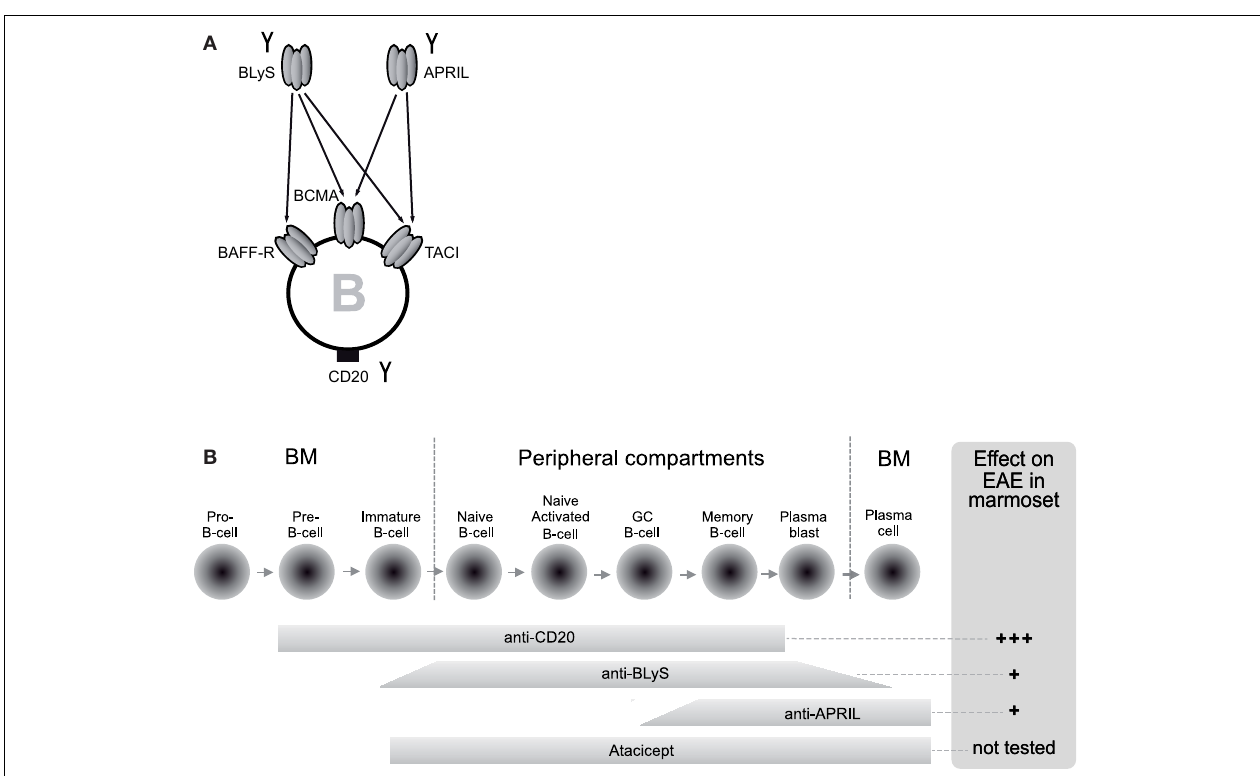
BAFF-R is specific for BLyS, whereas BCMA andTACI bind both factors. (B) Since the target of anti-CD20 mAbs is expressed throughout B-cell development, with the exception of pro-B-cells and plasma cells at the extreme ends, anti-CD20 mAb depletes a wide range of B cells.The narrower activity window of neutralizing antibodies against BLyS or APRIL or a soluble form ofTACI (atacicept) shows partial overlap with the expression of